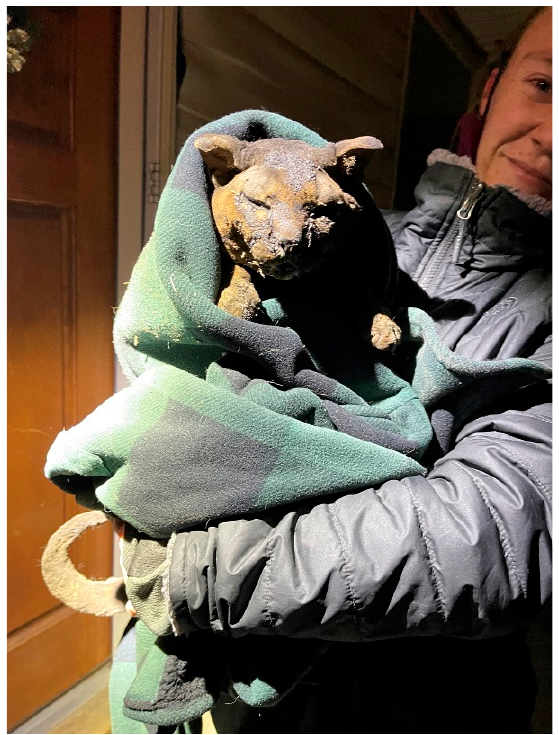
Figure 2. Merlin at the time of rescue. (Photo credit: Shelby Davis, Soul Dog